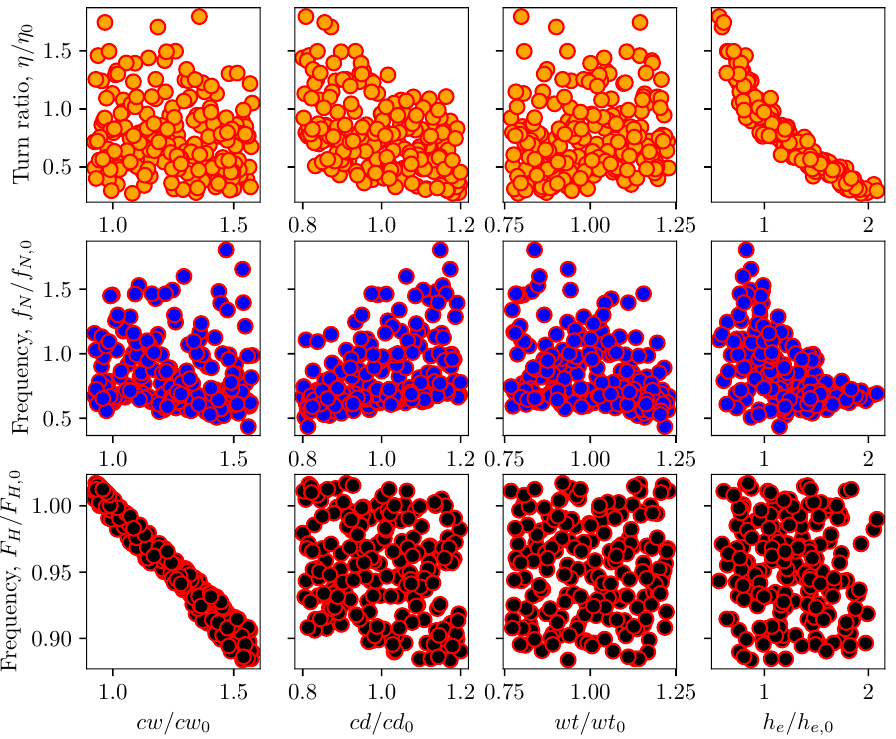
Figure 17. Scatter plot of inkjet channel frequency with geometrical parameters of channel width, depth, wall thickness, and electrode height. The parameters are normalized with the base channel of the existing RC1536 inkjet